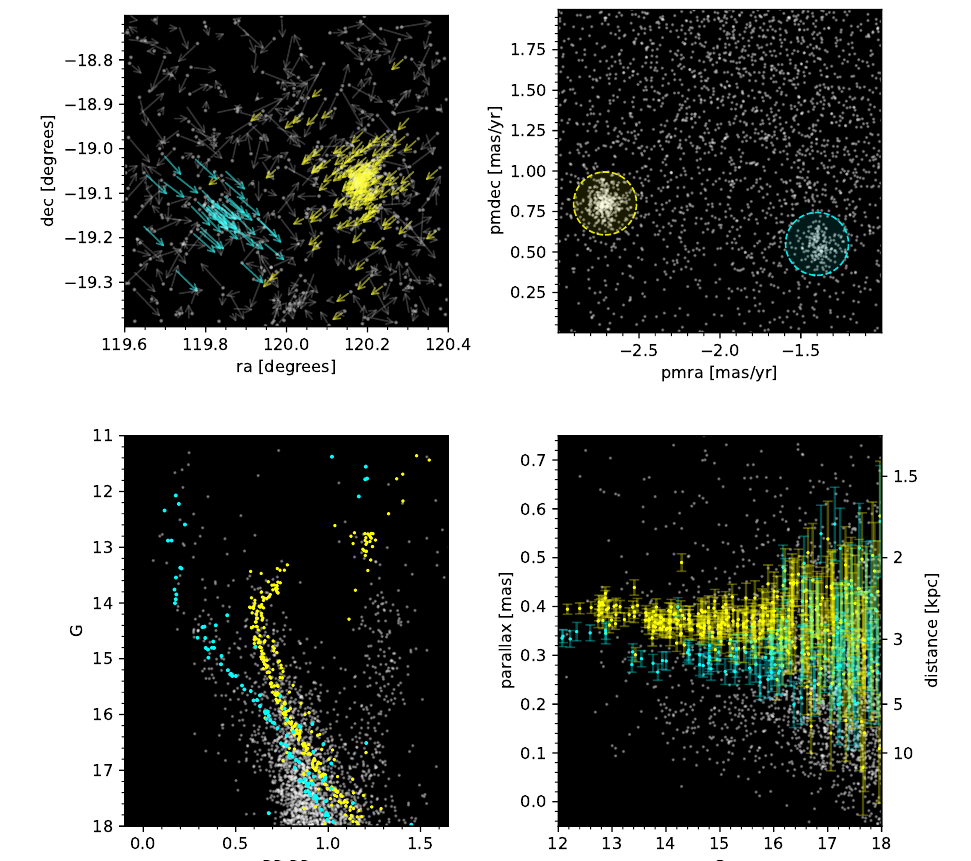
Figure 2. Example of two clusters (LP 589 in cyan and NGC 2509 in yellow) characterised with Gaia EDR3. The top-left panel shows the sky distribution of the stars and their vector proper motion. The top-right panel shows the distribution in proper motion space. The bottom-left panel shows the colour–magnitude diagram of the cluster stars, selected based on their proper motions, and the noncluster stars (white). The bottom-right panel shows the parallax distribution of the stars, which can be used to estimate distance to the